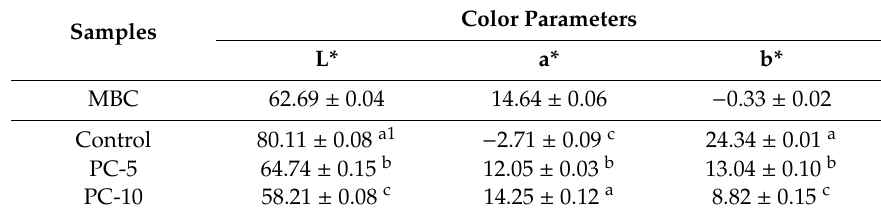
Table 4. The CIELAB color parameters (L*—lightness; a*—green-to-red; b*—blue-to-yellow) of investigated MBC and pastry cream samples with di ff erent levels of MBC (Control—0% MBC; PC-5—5% MBC; PC-10—10% MBC).